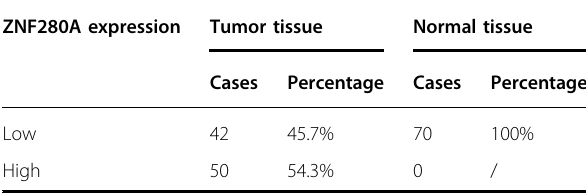
Table 1 Expression patterns of ZNF280A in lung cancer tissues and normal tissues revealed in immunohistochemistry